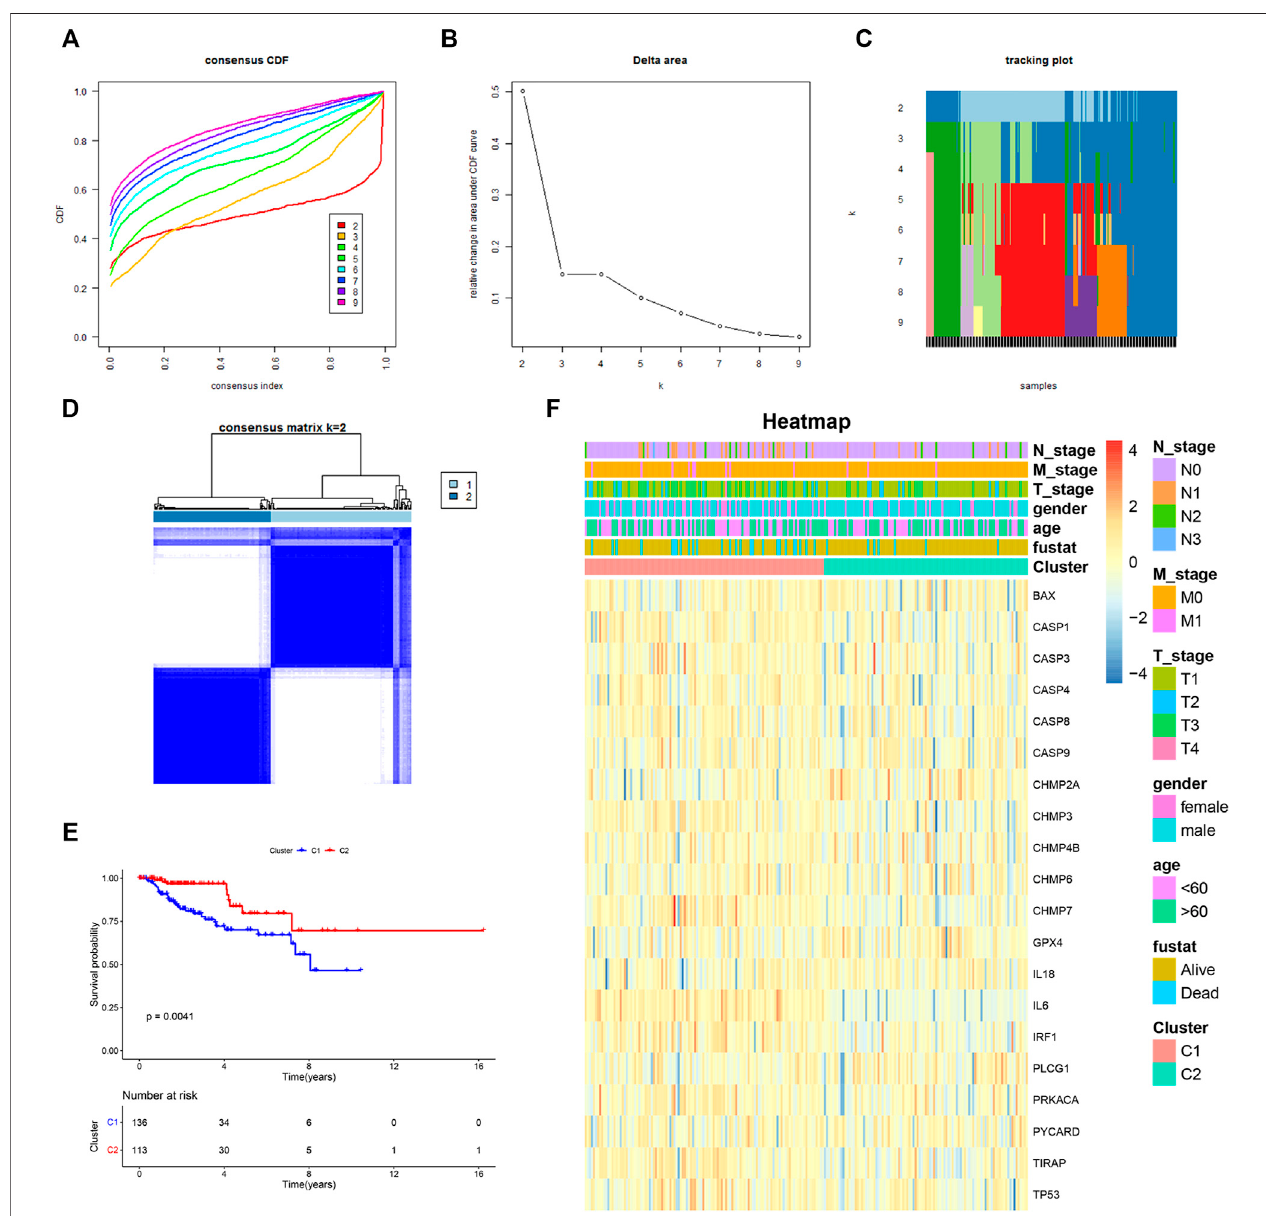
FIGURE 2 | Two KIRP clusters obtained by consensus clustering analysis based on differentially expressed PRGs. (A) Area under the cumulative distribution function(CDF)curvefork=2 – 9. (B) CDFdeltaareafork=2 – 9. (C) Trackingplotfork=2 – 9. (D) Consensusclusteringmatrixfork=2. (E) Kaplan – Meiersurvivalanalysis of two subgroups. (F) Heat-map of PRGs and the clinical characteristics between the two